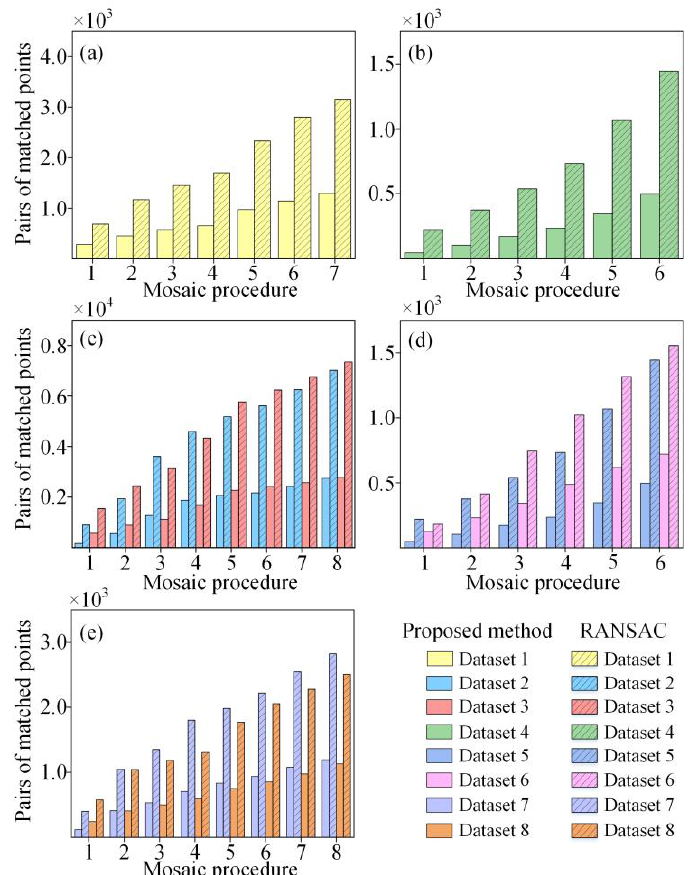
Figure 6. The UAV images used for crop growth monitoring using the proposed method and random sample consensus (RANSAC) to obtain the cumulative number of correctly matched feature points. ( a ) and ( b ) show the cumulative numbers of correctly matched feature points for the visible and thermal infrared UAV images of wheat, respectively; ( c ), ( d ), and ( e ) show the cumulative numbers of correctly matched feature points for the visible, thermal infrared, and near-infrared UAV images of rice, respectively.